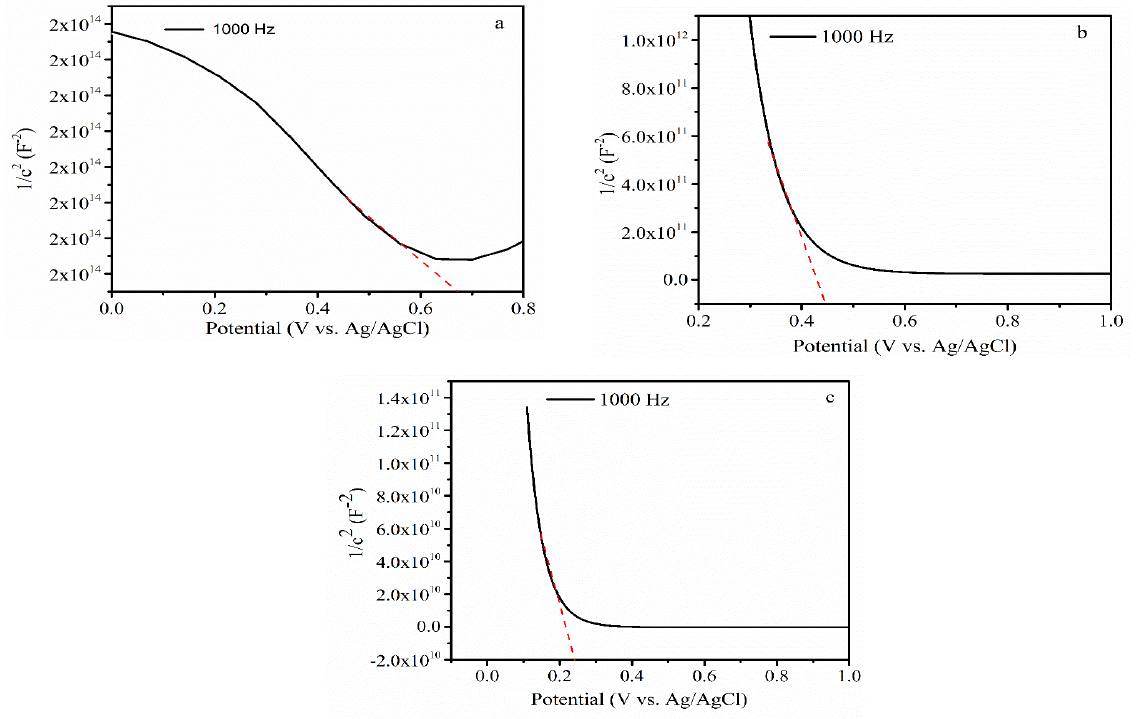
Figure 8: Mott-Schottky plots at a frequency of 1000 Hz in the dark of the (a) p-Si(100), (b) SiNWs photocathode prepared by etching 15 min, and (c) SiNWs photocathode prepared by etching 30